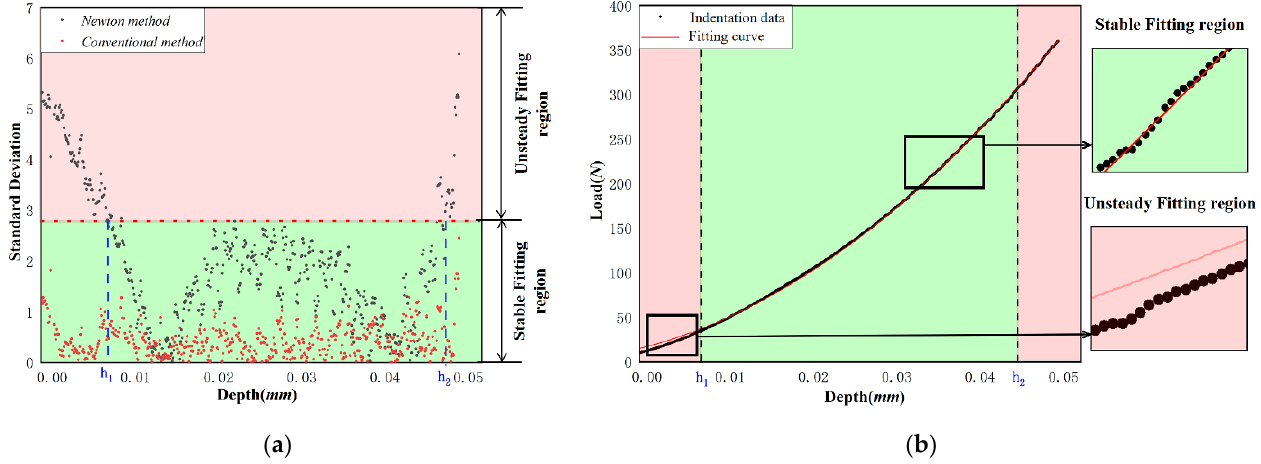
Figure 5. Analysis of standard deviation between fit curve and raw data: ( a ) fitting standard deviation of indentation measurement points; ( b ) indentation curve fitting stable zone division.